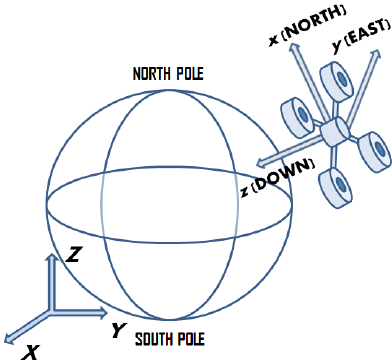
Figure 2. North–East–Down (NED)